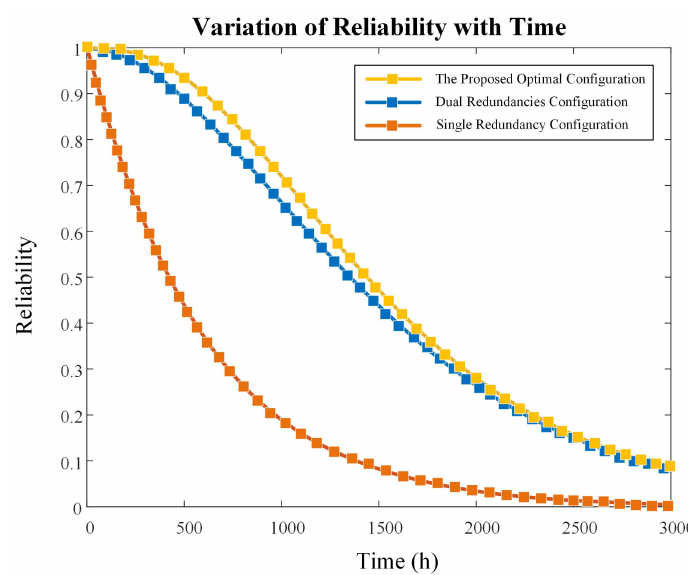
Figure 16. Reliability comparison among different